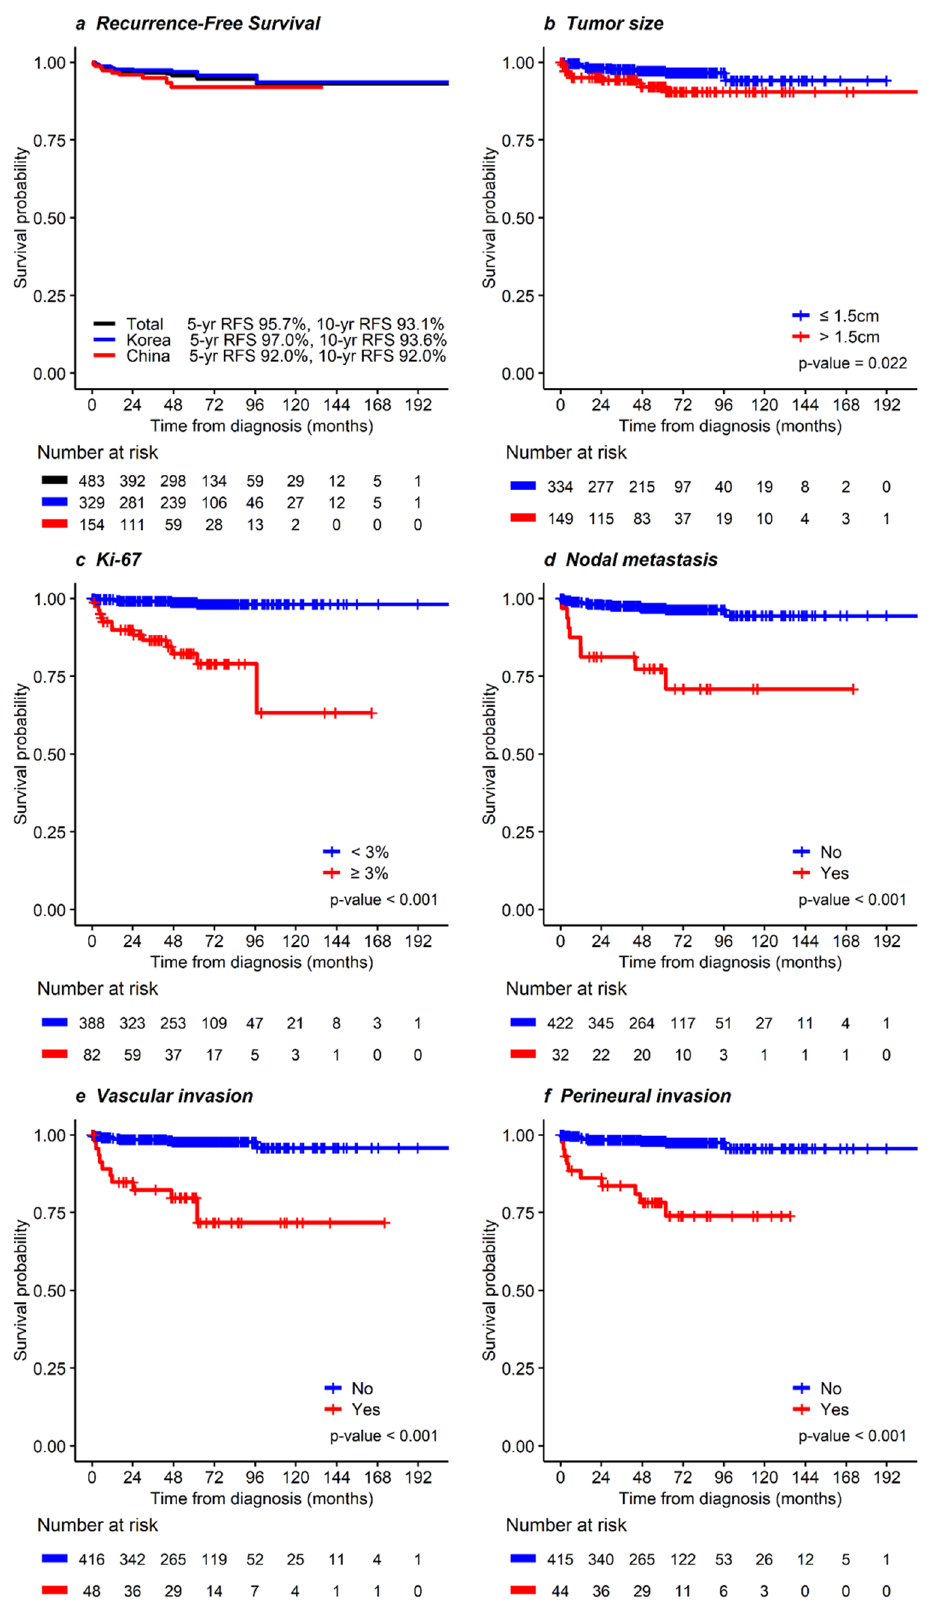
Figure 2. Kaplan-Meier curves for recurrence-free survival in patients with NF-pNET ≤ 2 cm. In ( a ) total, Korean, and Chinese patients and according to ( b ) tumor size ≤ 1.5 or > 1.5 cm, ( c ) Ki-67 index <3, or ≥ 3%, ( d ) nodal metastasis, ( e ) vascular invasion, and ( f ) perineural invasion.